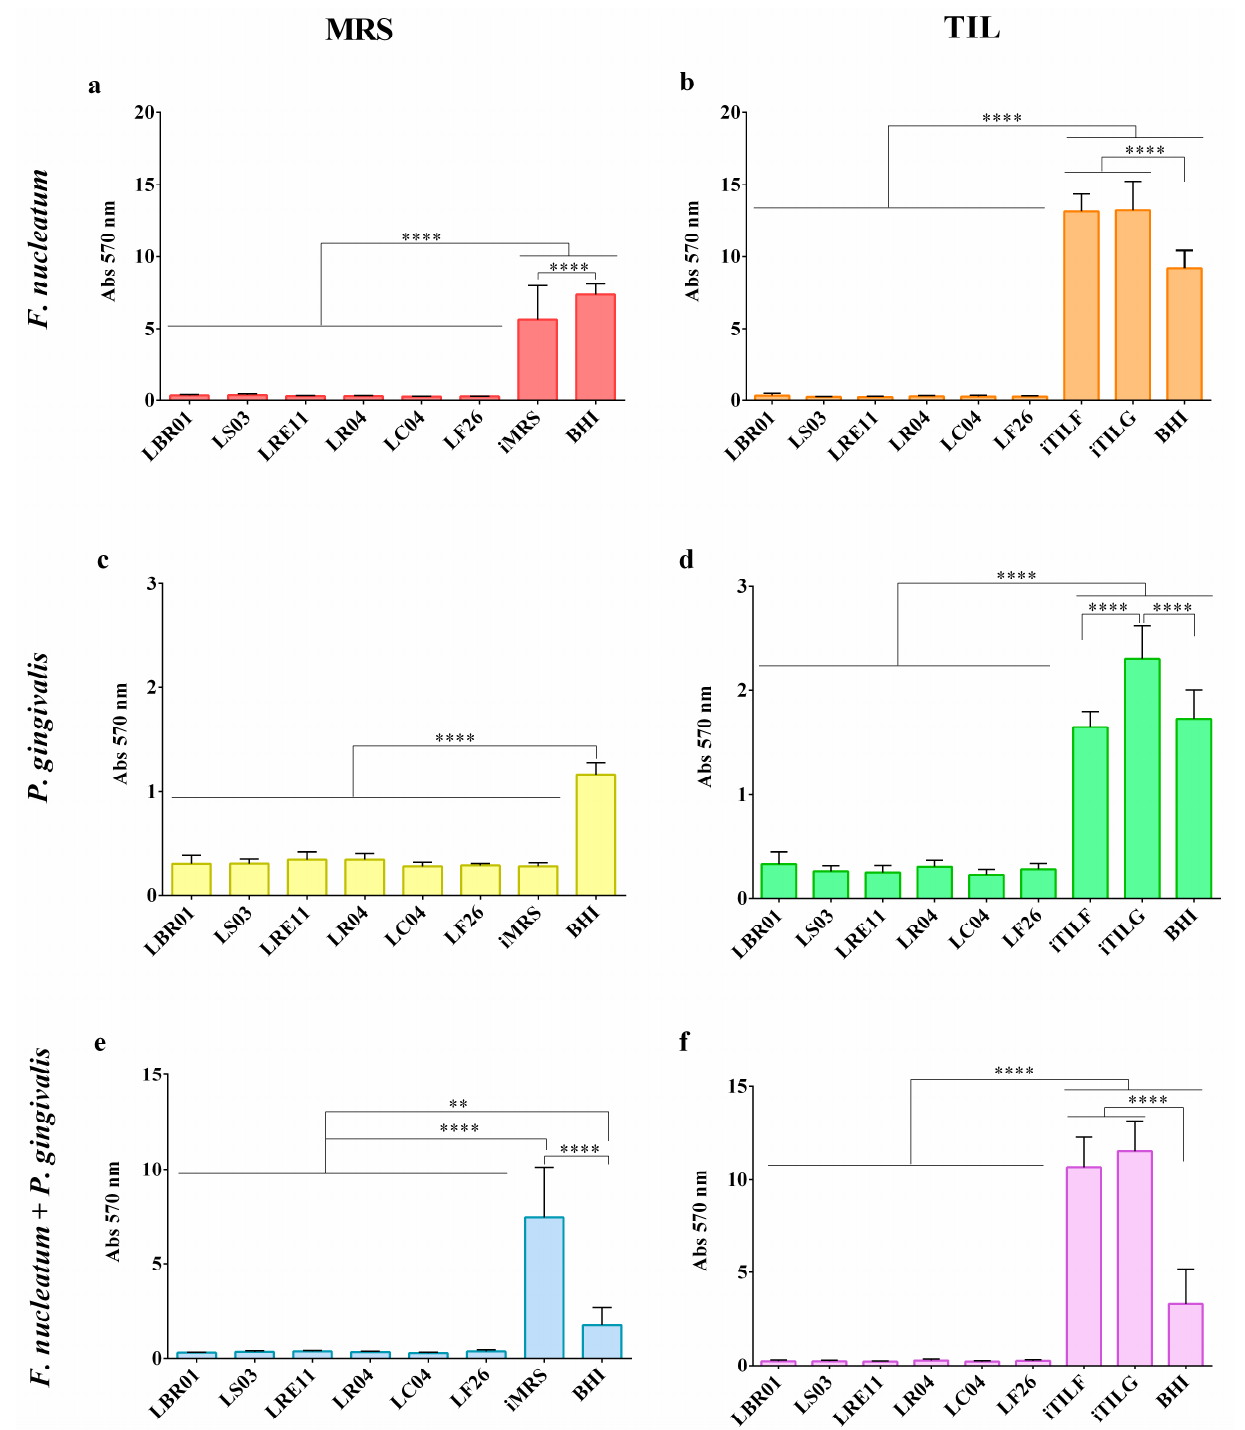
Figure 3. Crystal violet (CV) biofilm quantification. Pathogen biofilm quantification was determined after 72 h of probiotic CFS treatment in MRS: ( a ) F. nucleatum , ( c ) P. gingivalis , ( e ) F. nucleatum + P. gingivalis ; and in TIL: ( b ) F. nucleatum , ( d ) P. gingivalis , ( f ) F. nucleatum + P. gingivalis . Data are represented as the mean of three independent experiments ± SD. ** p < 0.01; **** p < 0.0001. Abs 570 nm = absorbance at 570 nm; CFS = cell-free supernatant.